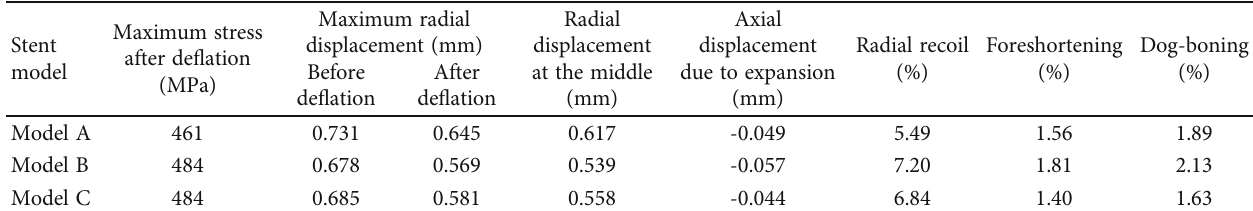
Table 4: Expansion characteristics of stent models with di ff erent strut connectors from simulation. Stent